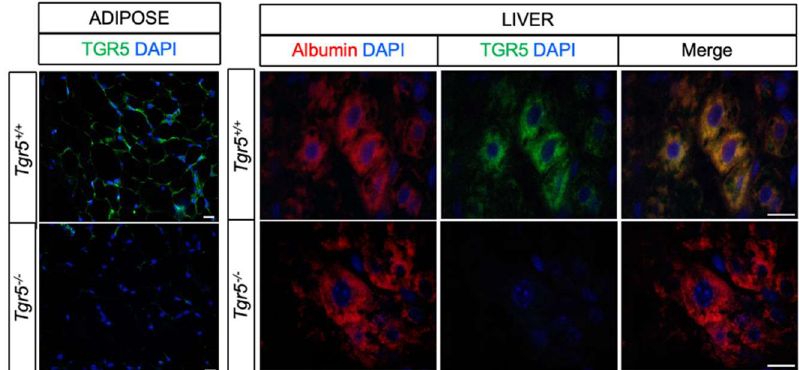
Figure 1. TGR5 is expressed in hepatocytes. Representative images of whole body TGR5 wild-type ( Tgr5 +/+ ) and knockout ( Tgr5 − / − ) mouse adipose and liver sections immunostained for TGR5 (green), albumin (red), and DAPI. Scale bar = 20 um.